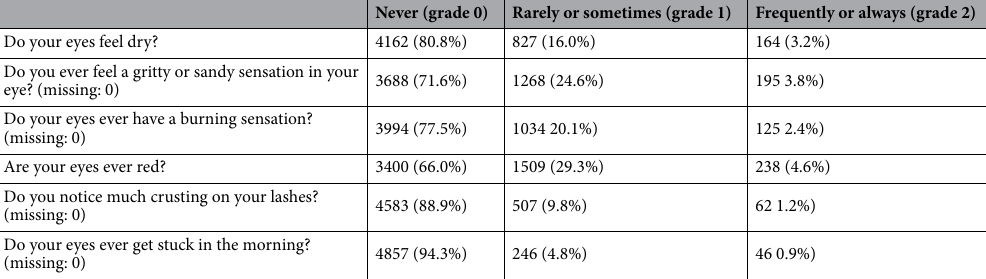
Table 1. Prevalence of dry eye symptoms.